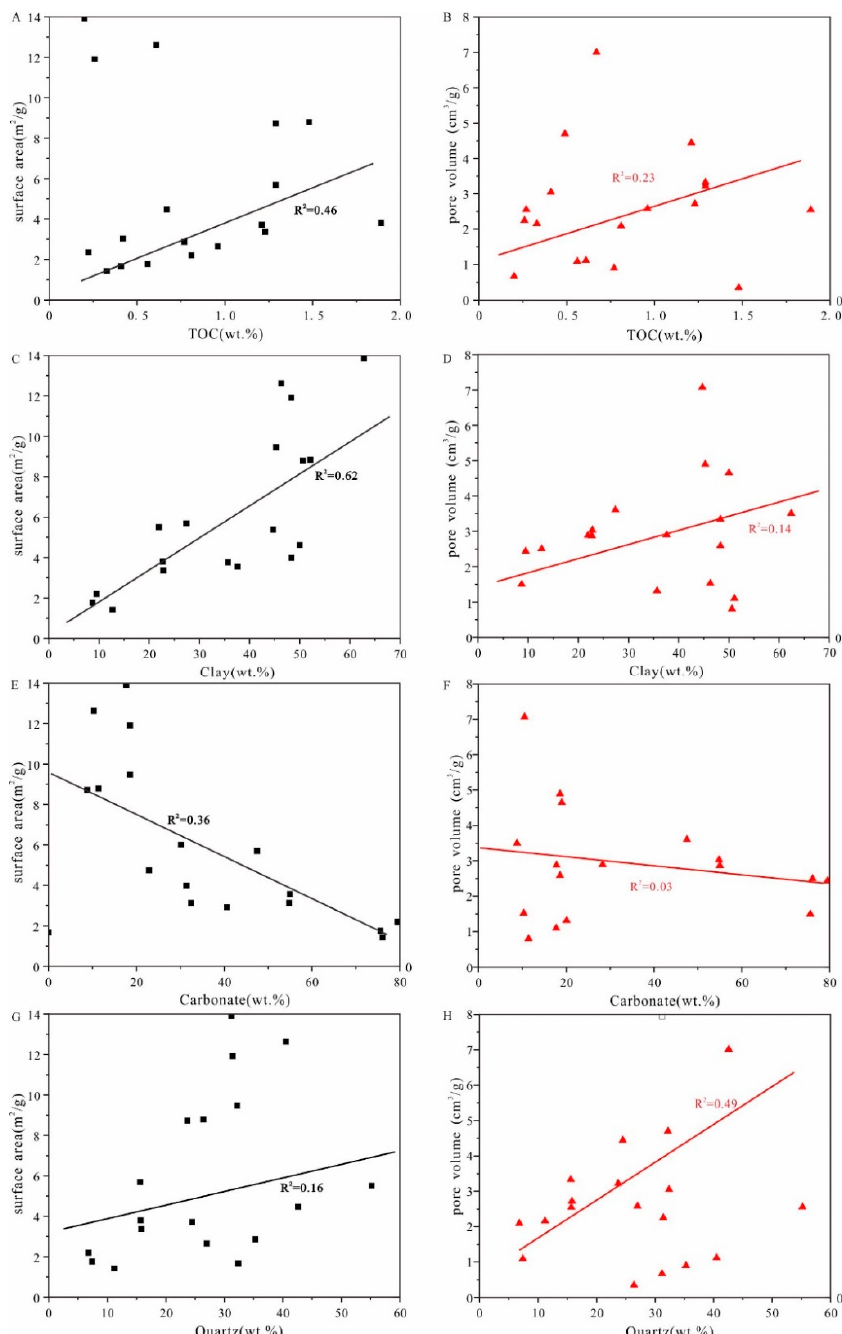
Figure 10. Correlation plots between specific surface area and pore volume and TOC and mineral composition. ( A ) The relationship between TOC and surface area; ( B ) The relationship between TOC and pore volume; ( C ) The relationship between clay and surface area; ( D ) The relationship between clay and pore volume; ( E ) The relationship between carbonate and surface area; ( F ) The relationship between carbonate and pore volume; ( G ) The relationship between Quartz and surface area; ( H ) The relationship between Quartz and pore volume.